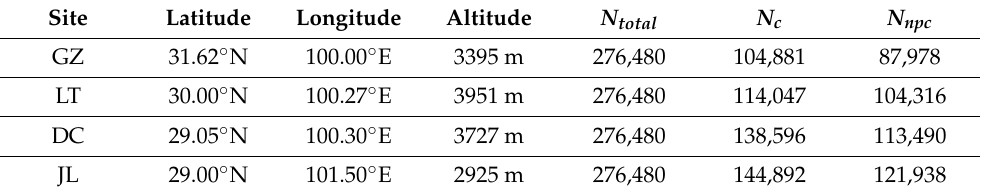
Table 1. The Ka-MMCR dataset samples at four sites from 5 June to 20 August